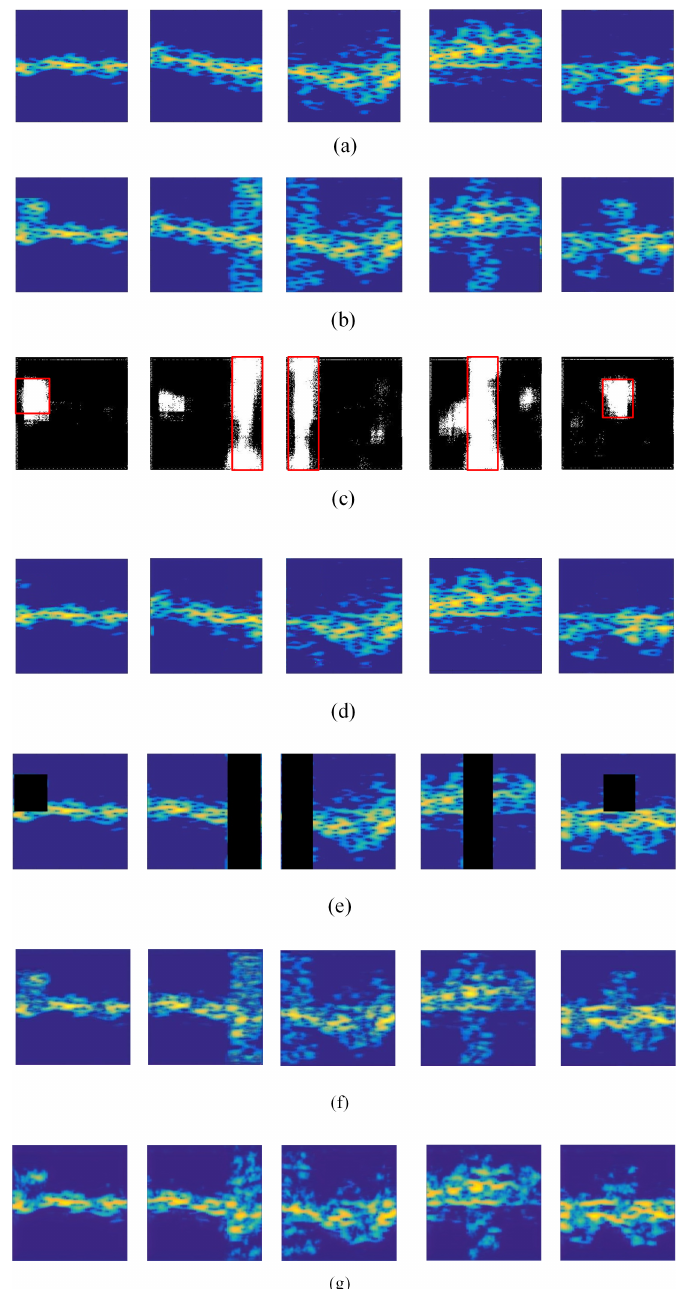
Figure 6. Results of the proposed hybrid FCN and GAN method and three state-of-the-art methods on the measured data. ( a ) The clean radar spectrograms. ( b ) The spectrograms with diverse types of interferences. ( c ) The locations of interferences detected by the proposed FCN model. The red boxes represent the ground truth of the locations of interferences. ( d ) The radar spectrograms restored with our method. ( e ) The spectrograms restored with Zeroing . ( f ) The spectrograms restored with FCNs . ( g ) The spectrograms with restored ResNet